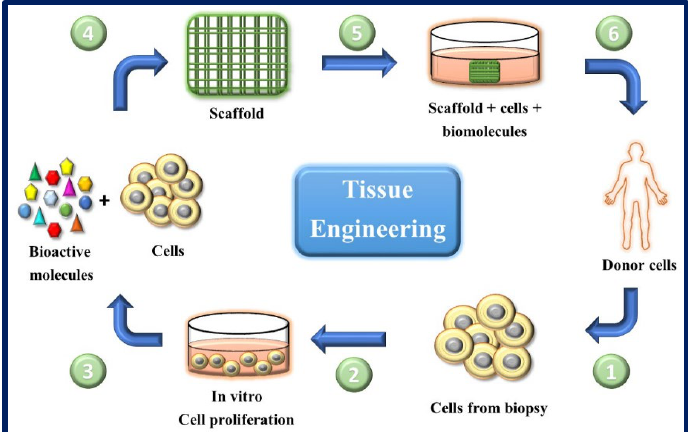
Figure 15. General scheme of the ideal circuit in regenerative therapies combining cells with appro- priate molecules and biomaterials. priate molecules and biomaterials. (1) Obtaining cells from the patient (for example, from a skin biopsy). (2) In vitro culture and expansion of autologous cells. (3) and (4) cells are seeded on scaffolds along with biomolecules of interest. (5) The scaffold-molecules-cells system is pre-incubated under optimal conditions. (6) The scaffold is implanted in the